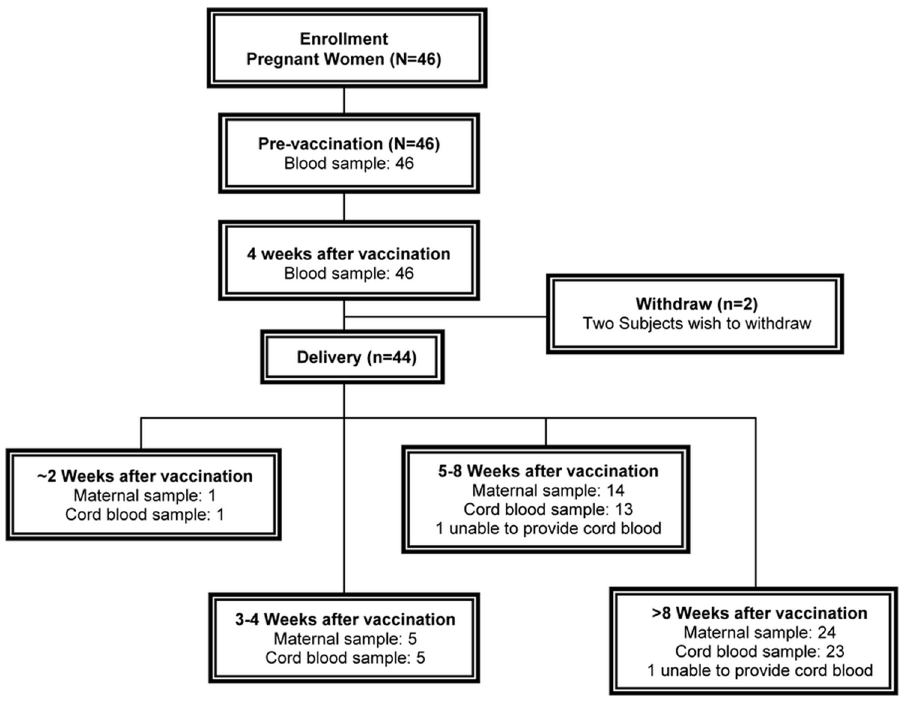
Figure 1. The trial profiles.